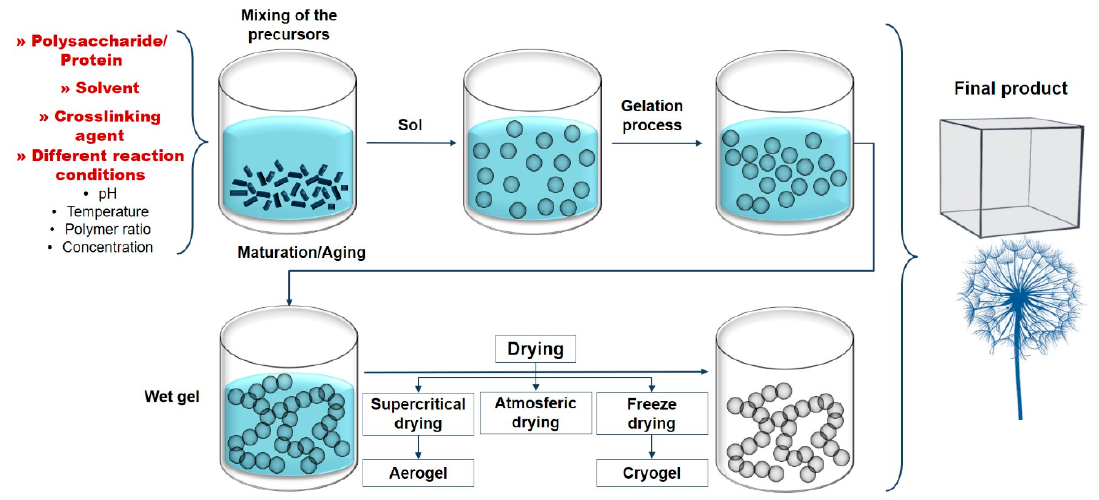
Figure 3. Methods for obtaining bio-based aerogels.